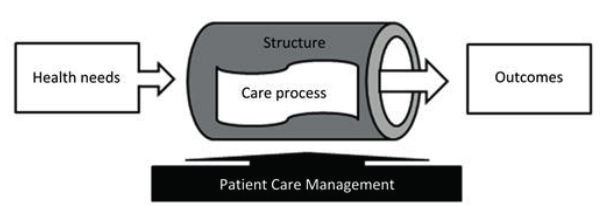
FIGURE 2 - Representation of the Donabedian structure– process–outcome model as it applies to the provision of clinical